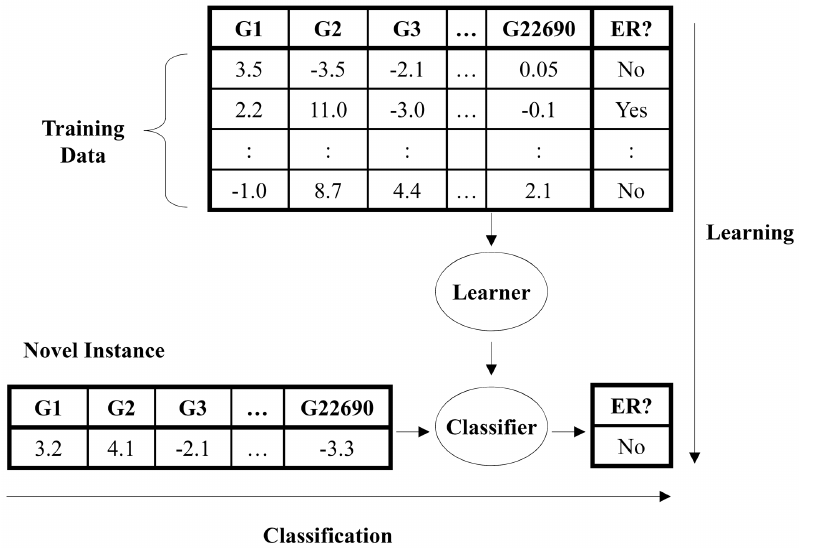
Figure 1. Basic machine learning framework. The bottom portion of this figures shows that a ‘‘Classifier’’ takes as input a description of a novel instance (here, the 27688 gene expression values from a microarray taken from a patient’s biopsy), and returns a prediction for this instance (here, its prediction of whether this tumor is ER + or ER 2 ). The figure suggests this response is ‘‘No’’. The Machine Learning challenge is to produce this classifier from a dataset of historical data (called labeled ‘‘Training Data’’); this is the vertical portion, showing that a Learner uses that Training Data to produce the classifier. When evaluating the quality of a learned classifier, we require that the ‘‘Novel Instance’’ is not in the Training Data.